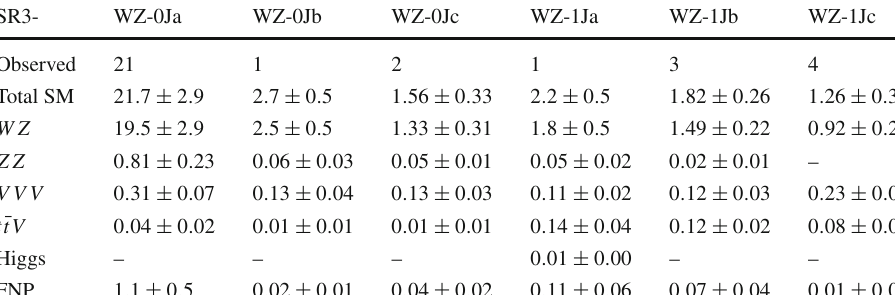
for SR3-slep-a to SR3-slep-e in the 3 (cid:4) channel. All systematic and statistical uncertainties are included in the